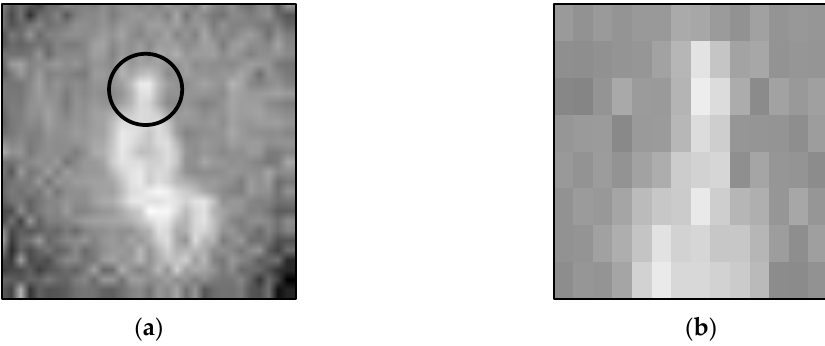
Figure 4. ( a ) TIS image depicting the sitting class where the circle indicates the region that is enlarged and ( b ) enlarged region of the inhabitant’s face.